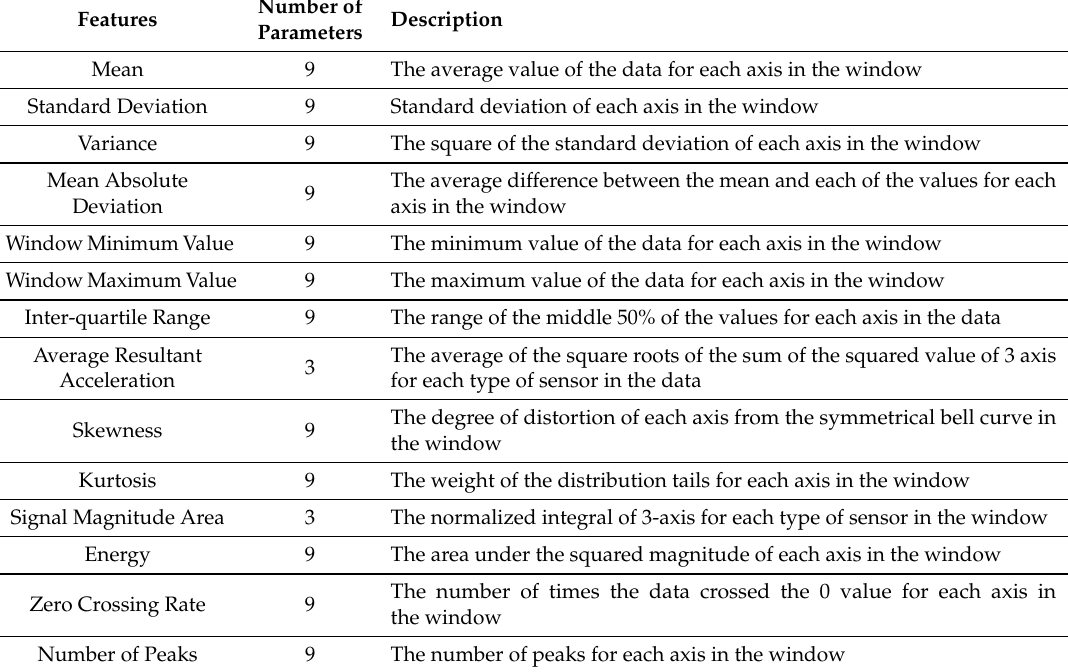
Table 2. List of features and description for the investigation of recognition of smartphone activities with inertial measurement unit (IMU)